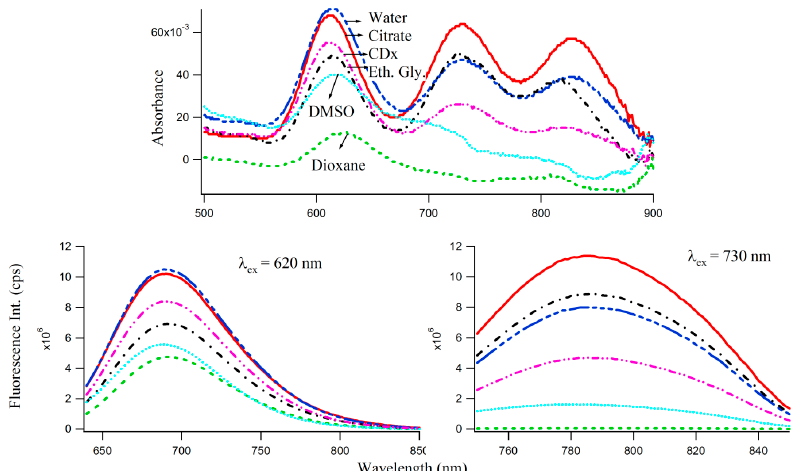
Figure 7. Influence of solvent polarities on the absorption ( top ) and fluorescence ( bottom ) spectra of 7.5 μ M3T4G templated Ag-NCs (with 45 μ M AgNO 3 and 45 μ M NaBH 4 ). Descriptions of the lines are given in the top figure (absorption spectra) which are same in bottom (emission spectra of Species I ( left ) and Species II ( right )).